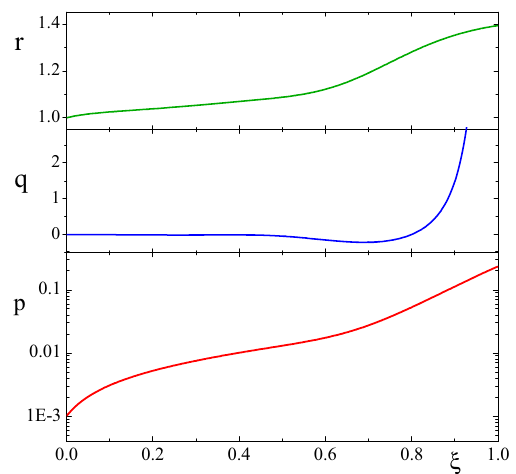
Fig. 2 Equations (29) and (30) as regards coefficient dependence on the parameter ξ for 400 GeV protons channeled by (110) Si planes